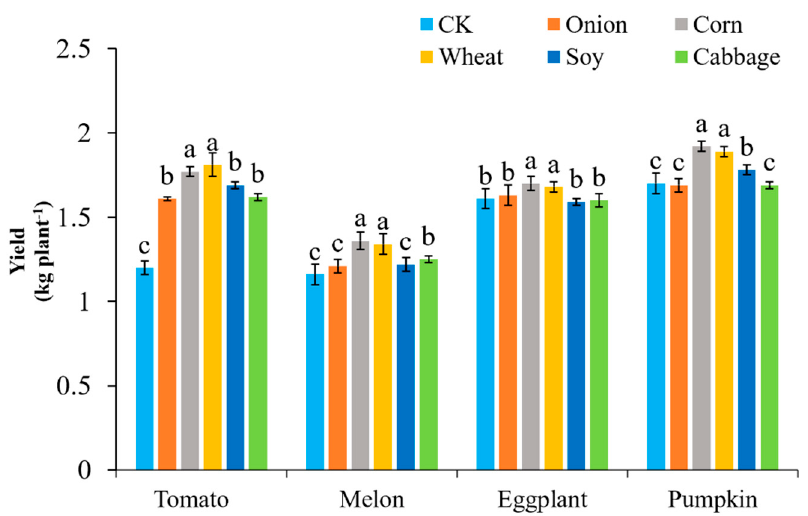
Figure 4. Effects of different catch crops on the yield of vegetables. Different small letters represent significant difference at 0.05 level by Duncan’s test.